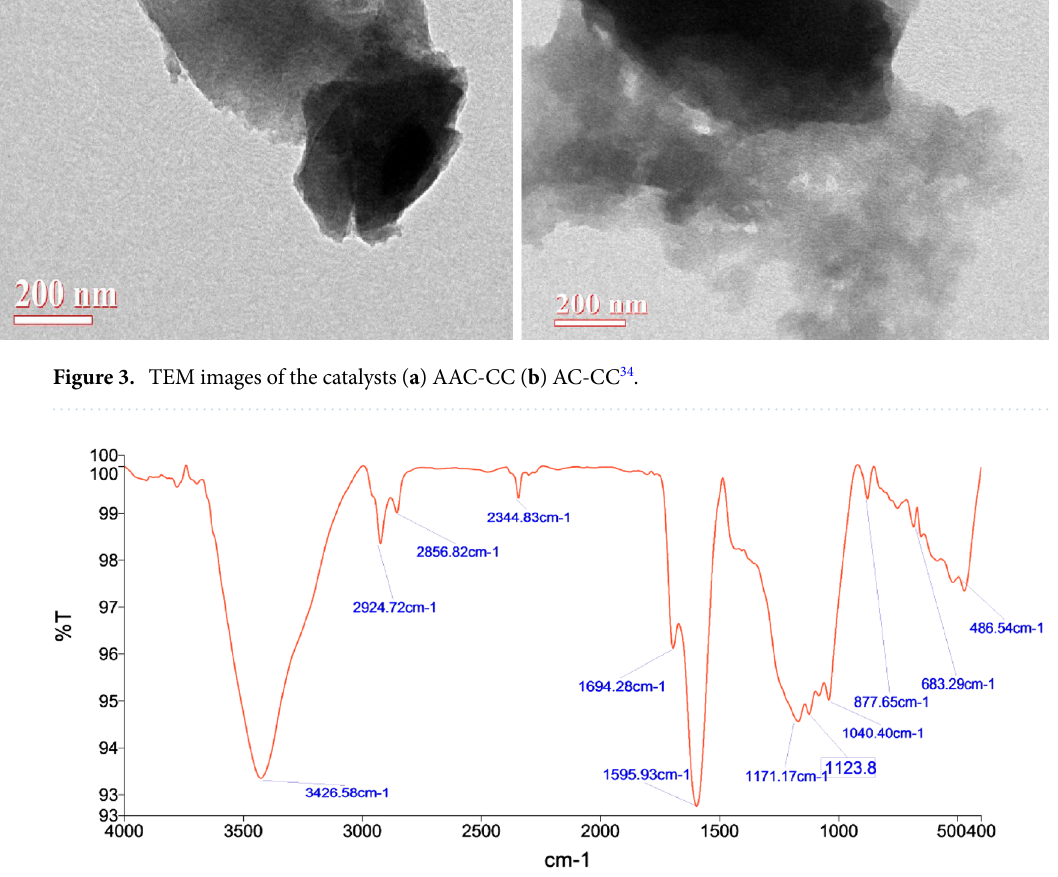
Figure 4. FTIR patterns of the derived activated carbons